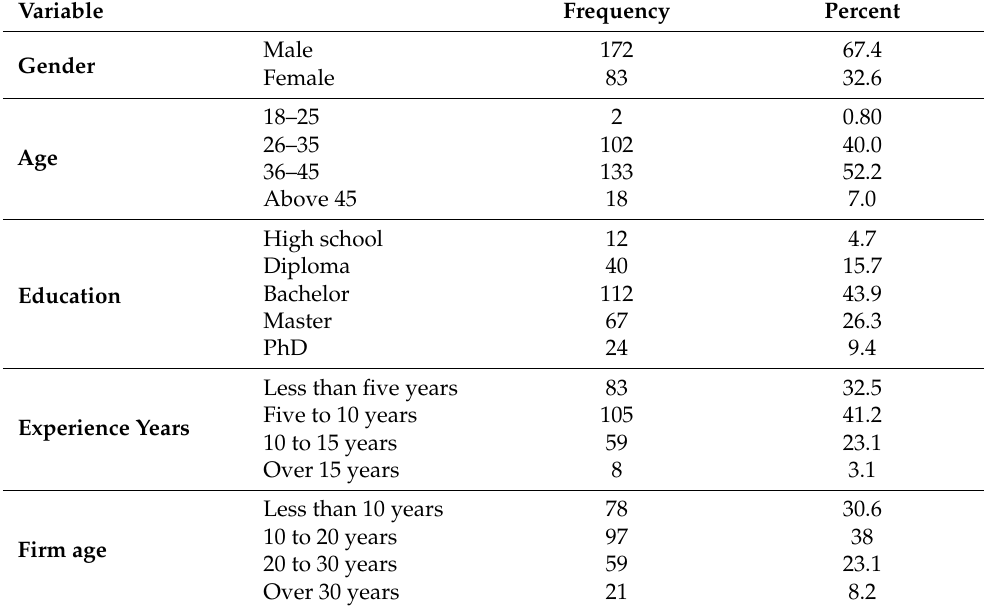
Table 1. Demographic data of respondents.